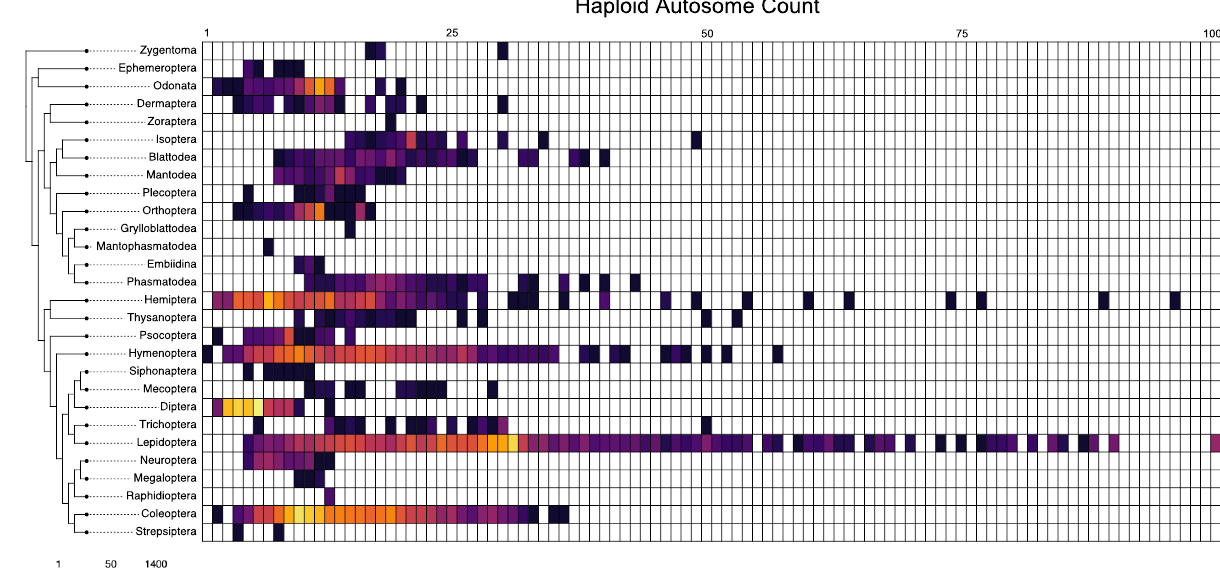
Figure 1. Haploid autosome counts in insects. Each row represents an order of insects and each column indicates a haploid autosome count for the homogametic sex. The shading of each cell repre- sents the number of records with a given haploid count with colors on a log scale. The final column holds the count of all haploid autosome numbers of 100 or higher (22 all in the order, Lepidoptera).